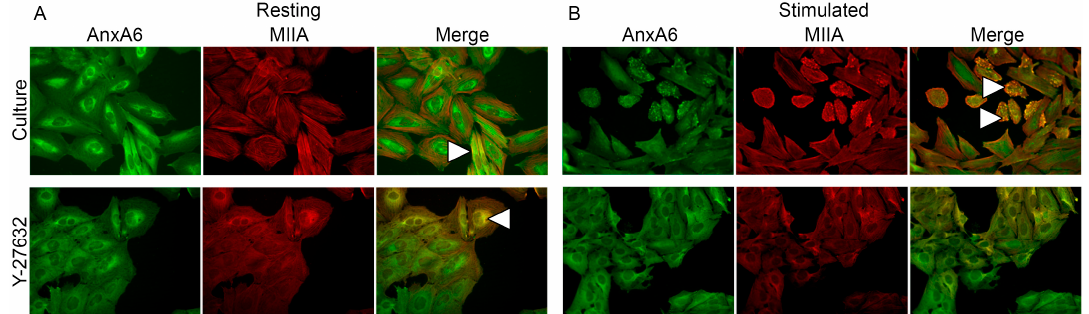
Figure 5. Co-localization of AnxA6 with non-muscle myosin II (MII) in Saos-2 cells, non-treated or treated with inhibitors, in resting conditions ( A ) or after seven-day stimulation with AA and β -GP ( B ). The cells were incubated with appropriate antibodies: mouse monoclonal anti-AnxA6 linked with goat-anti mouse IgG-FITC and rabbit polyclonal anti-MIIA linked with goat anti-rabbit IgG-tetramethylrhodamine (TRITC) and was observed under an Axio Observer Z1 fluorescent microscope (Carl Zeiss, Oberkochen, Germany) with phase contrast and appropriate fluorescent filters, magnification 240 × . The yellow color and arrowheads on the merge images indicate protein co-localization. Data of a typical experiment are